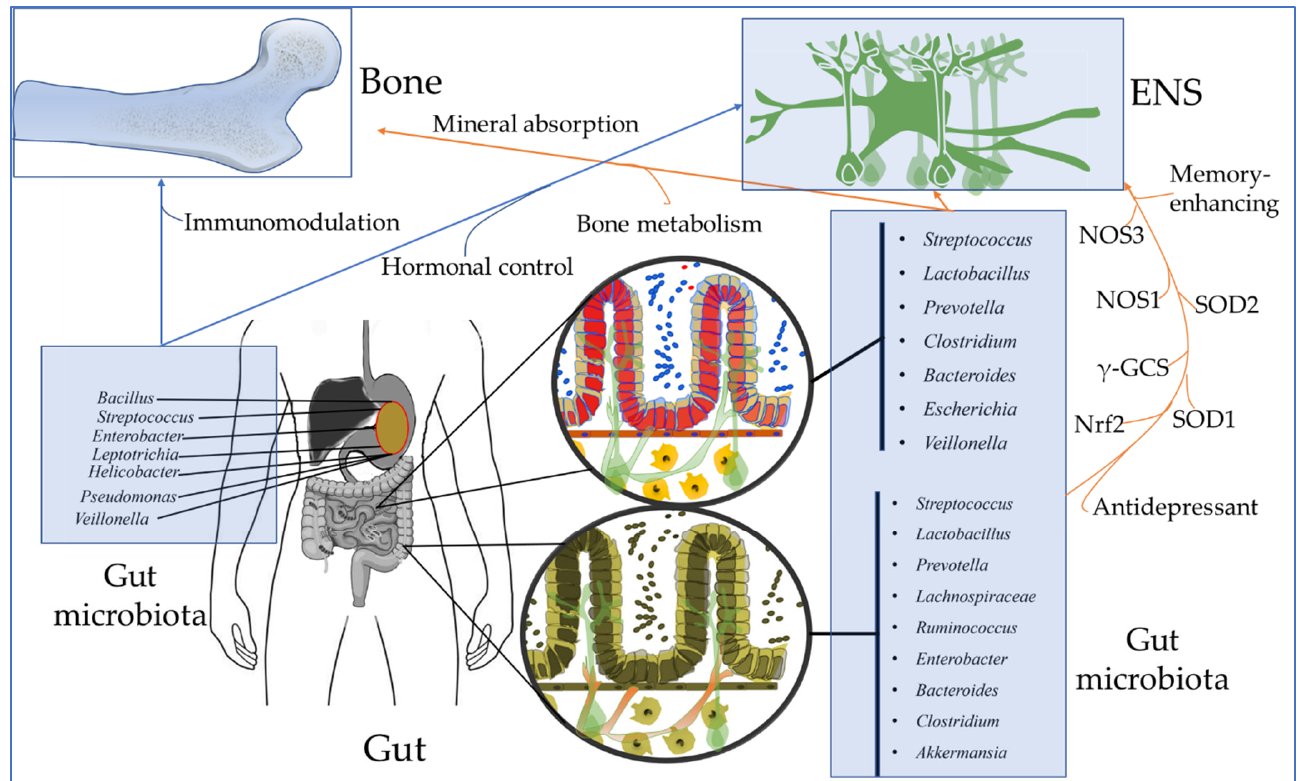
Figure 4. Influence of gut microbiota on enteric nervous system and bone development. The gut microbiota is known to affect the ENS via the NOS 3 , NOS 1 , SOD 2 , SOD 1 , Nrf2, γ‐ GCS. Gut microbiota is also known to demonstrate immunomodulation, hormonal control, and mineral absorption activities, and metabolism of bones.